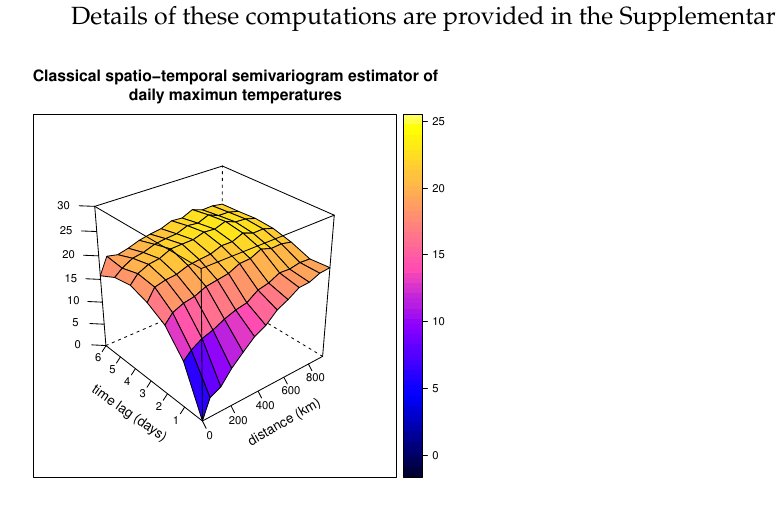
Figure 4. Three-dimensional picture of the classical spatio-temporal semivariogram estimator of the daily Tmax from the NOAA data for July